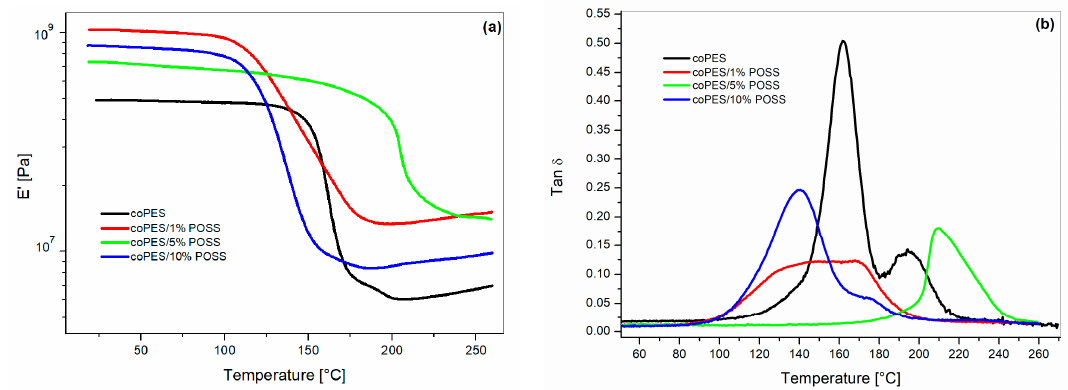
Figure 15. DMA analysis of the cured laminates: ( a ) storage modulus ( E ’) vs T ; ( b ) tan δ vs T .